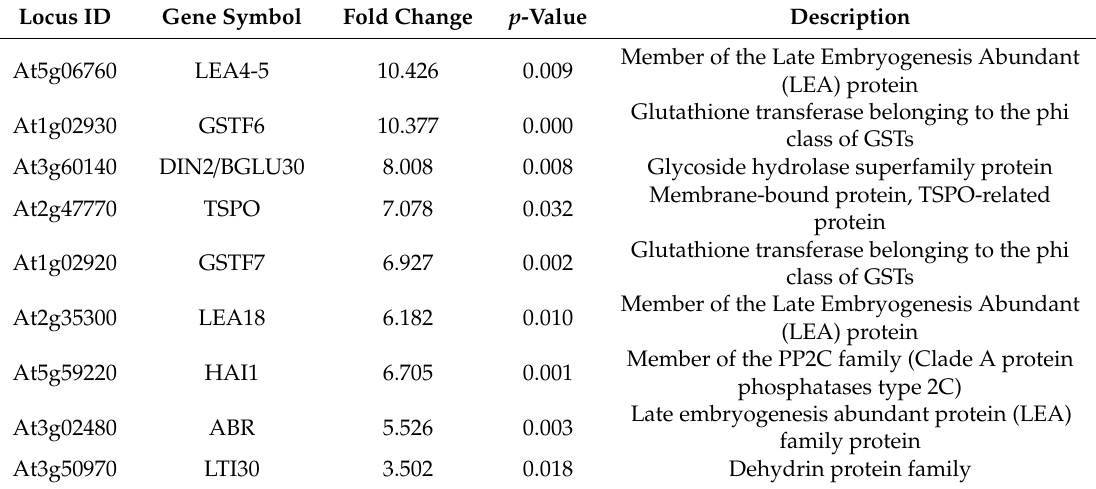
Table 5. List of nine stress-responsive genes selected from Genevestigator analysis. Locus